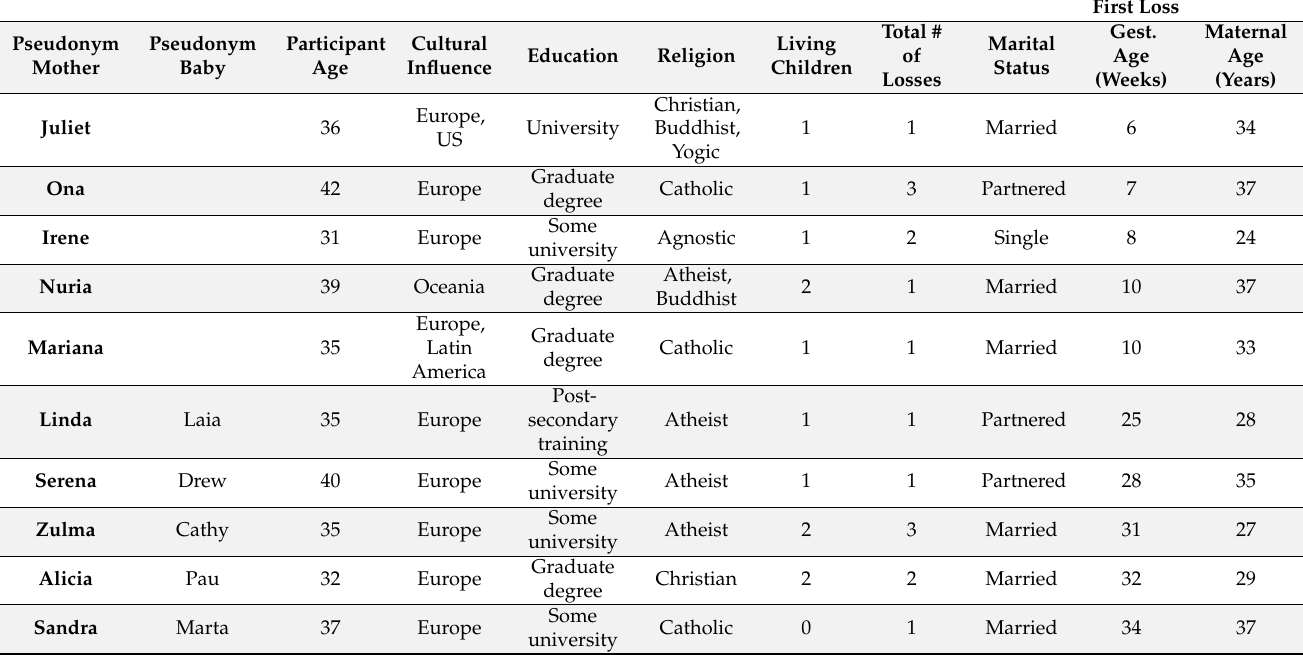
Table 1. Descriptive